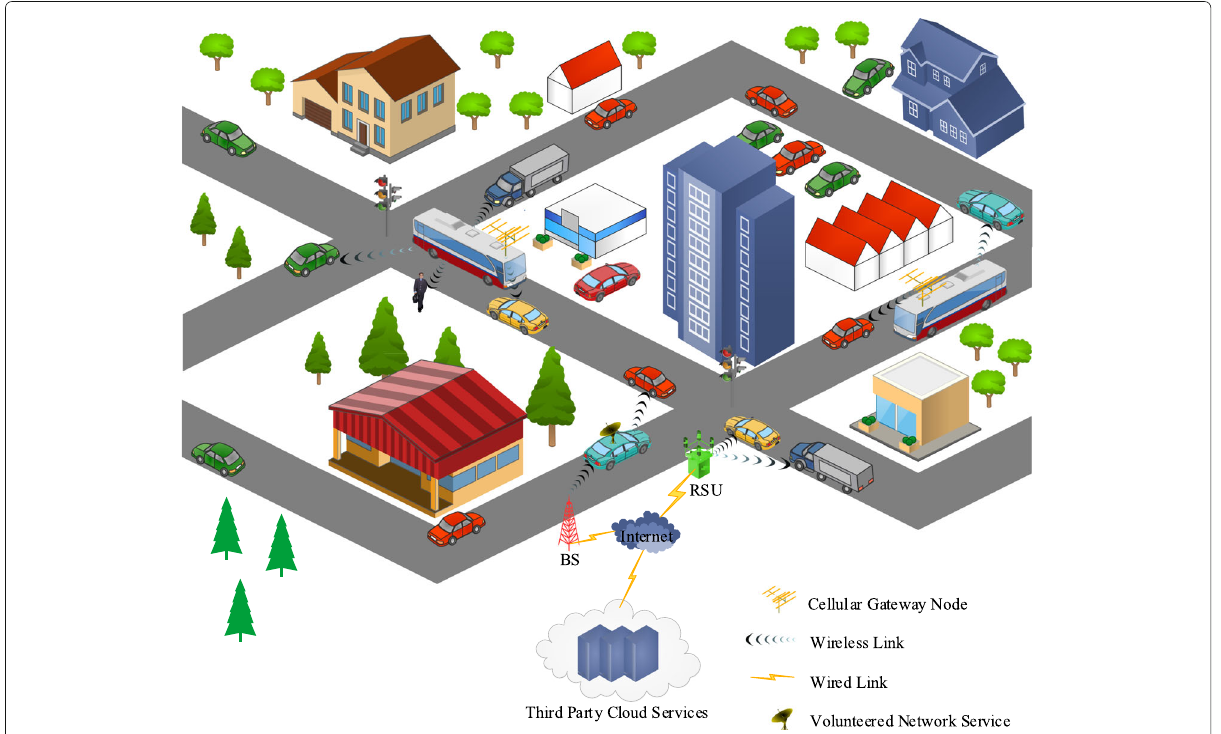
Fig. 5 VCC—Network as a Service Usage of vehicular network to support network